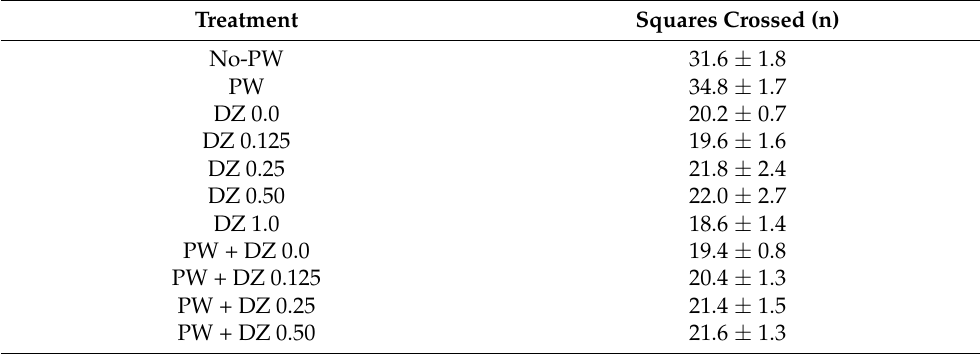
Table 1. Effect of progesterone withdrawal and different doses of diazepam on the total number of squares crossed in the locomotor activity test in Wistar Kyoto rats.